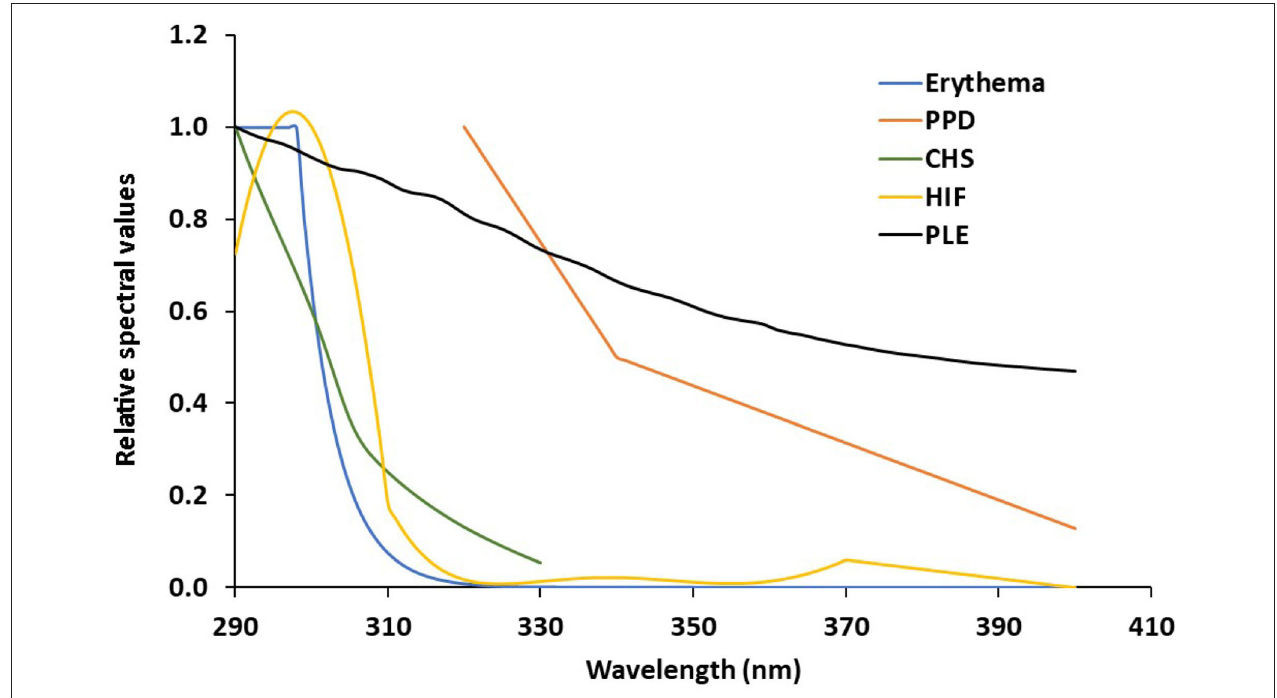
FIGURE 1 | Spectral absorbance of PLE related to the different action spectra analyzed (Erythema; PPD, Persistent Pigment Darkening; CHS, Contact Hypersensitivity factor; HIF, Human Immunoprotection Factor; PLE, Polypodium leucotomos extract, Fernblock ® ).